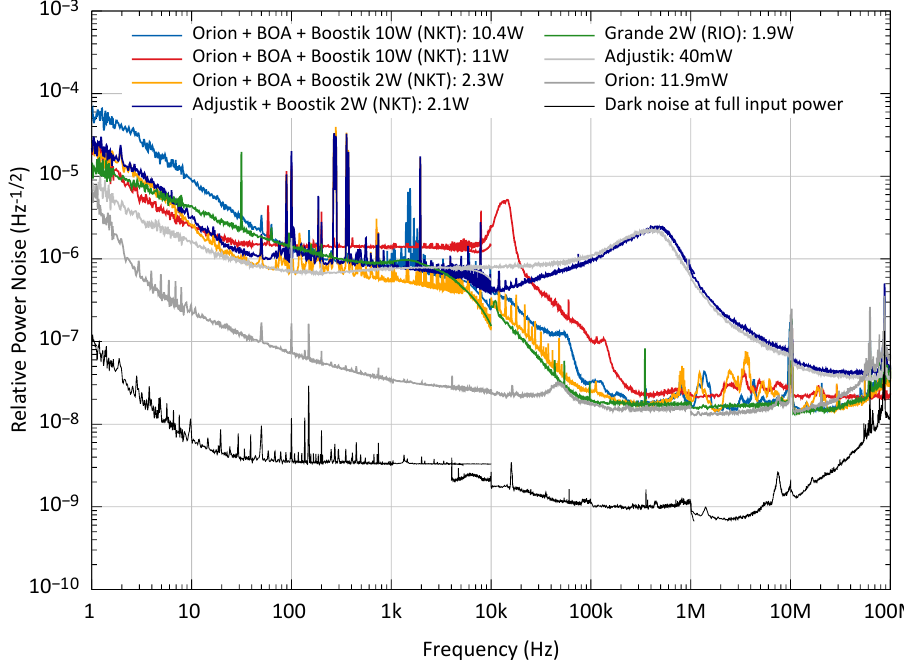
Figure 9. The free-running RPN spectral densities at the output of the power amplifiers is shown. At low frequencies, the power noise of the power amplifiers is dominated by their pump power noise. The relaxation oscillation frequency of the fiber seed laser is at or above the corner frequency of this transfer function. Thereby, its magnitude in a relative power noise spectral density is not attenuated, as can be seen in the power amplifier’s output noise in Figure